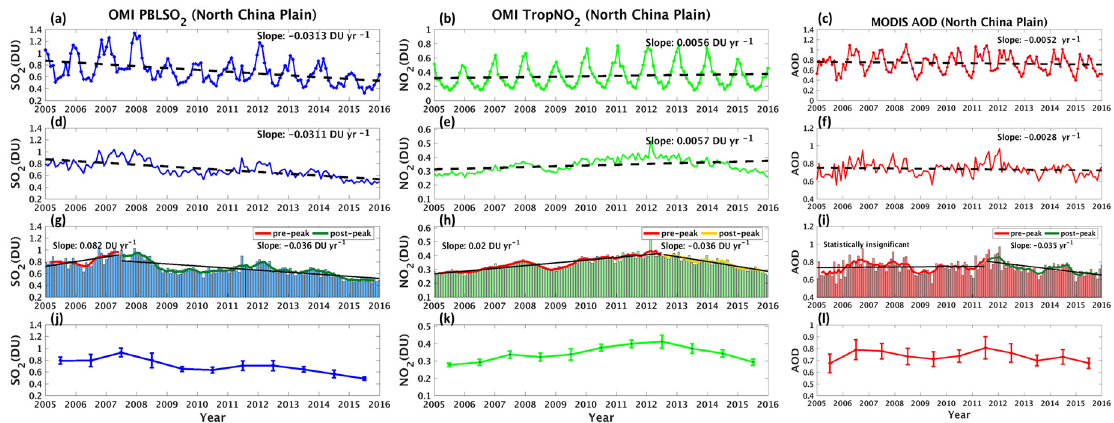
Figure 5. Long term trends of SO 2 , NO 2 , and AOD over the North China Plain. ( a – c ) original with overall trend line, ( d – f ) seasonally adjusted time series with overall trend line, ( g – i ) five-month moving average with pre-peak and post-peak trend lines and histogram for seasonally adjusted data, and ( j – l ) yearly mean time series.